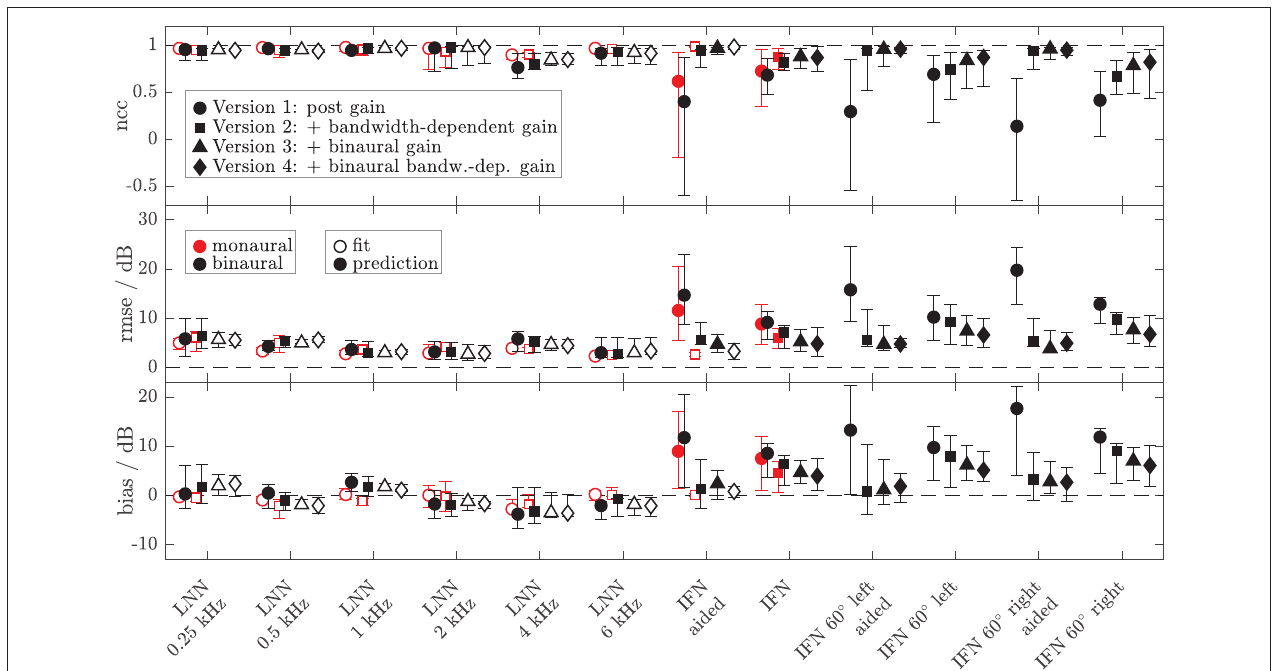
FIGURE 8 | Median (symbols) and 25 and 75 percentiles (bars) of the model performance measures (top panel: ncc, middle panel: rmse, bottom panel: bias) for monaural (red, mean value across left and right ear per listener) and diotic (black) conditions across the subgroup of four HI listeners for which loudness data of broadband IFN stimuli were collected in Dataset 1. The dashed lines indicate optimal performance. Four different model versions were tested as described in the Method section of experiment II (circles: version 1 with monaural post gain, squares: version 2 with additional monaural bandwidth-dependent gain, i.e., individualized parameters β L and β R , triangles: version 3 with additional overall binaural gain, i.e., individualized parameter α B , diamonds: version 4 with additional binaural-bandwidth-dependent gain, i.e., individualized parameter β B ). Open symbols mark the conditions that were utilized in the model fits. Filled symbols indicate model